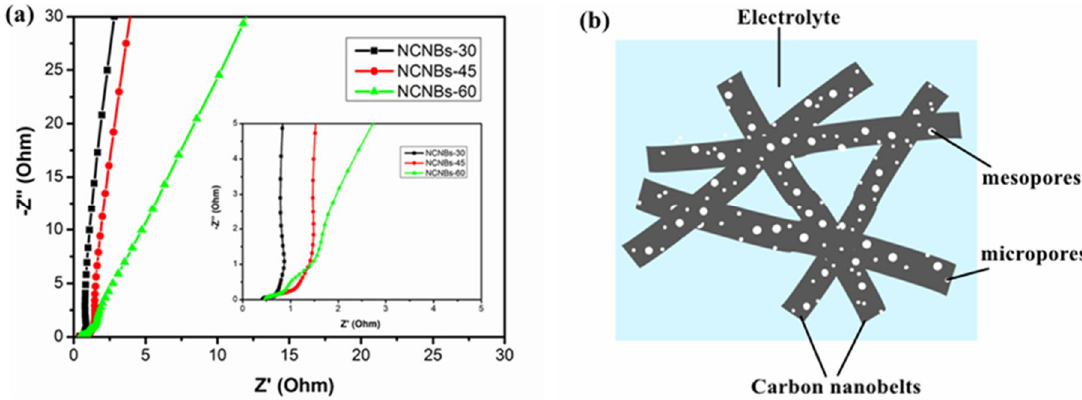
Figure 7. ( a ) Nyquist plots of NCNBs lectrodes and ( b ) Schematic illustration of the electrode prepared from NCNBs-45.